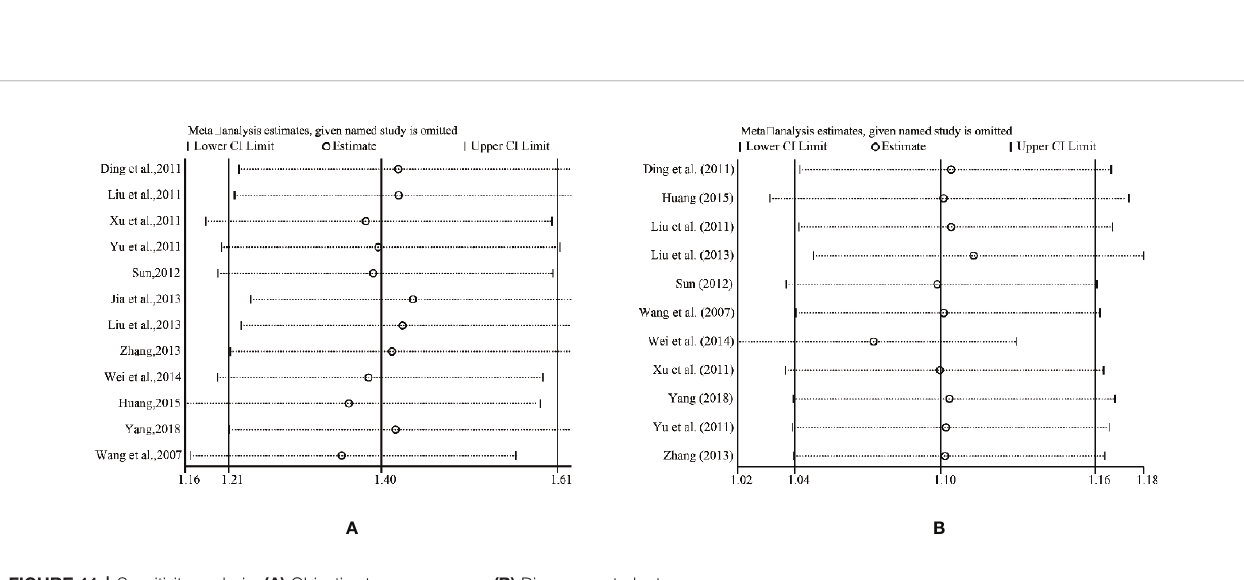
FIGURE 11 | Sensitivity analysis. (A) Objective tumor response. (B) Disease control